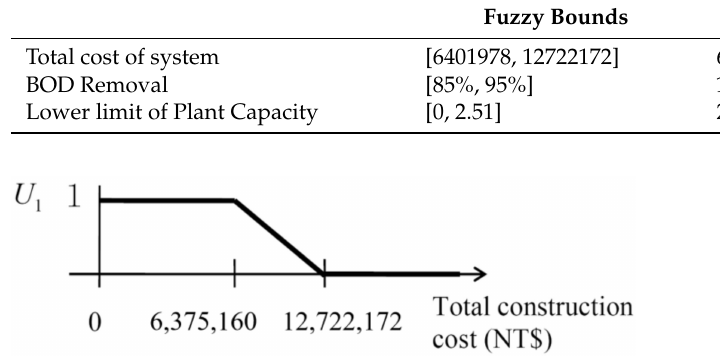
Figure 3. Membership function of the total cost of the system.